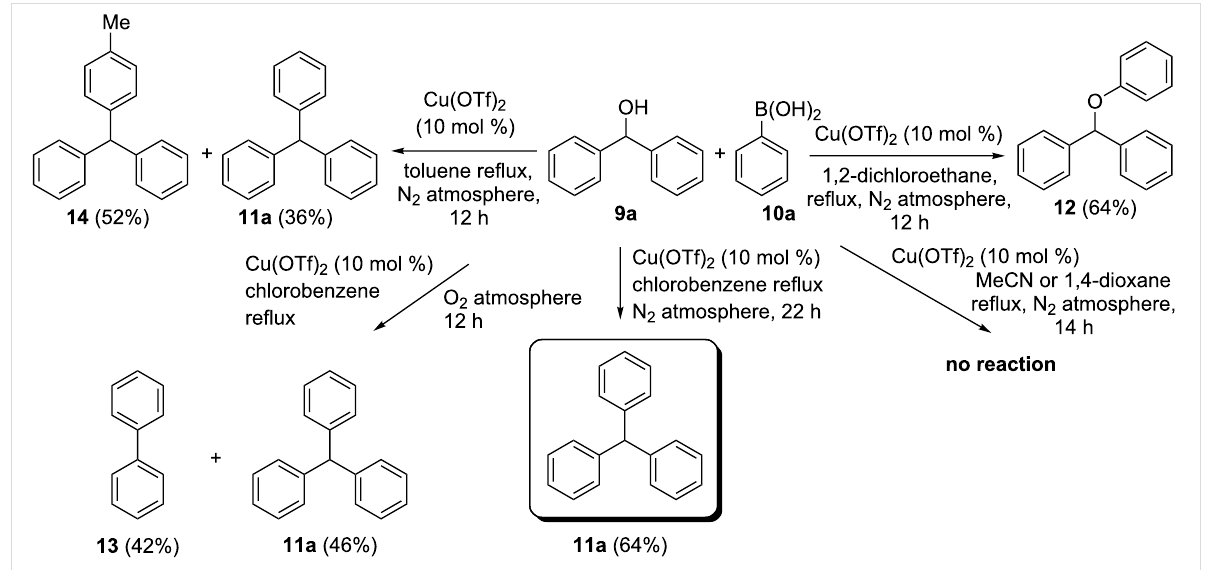
Scheme 2: Role of solvent and reaction conditions in the Cu(OTf) 2 -mediated coupling of diphenylmethanol ( 9a ) with phenylboronic acid ( 10a ) for the preparation of triphenylmethane ( 11a